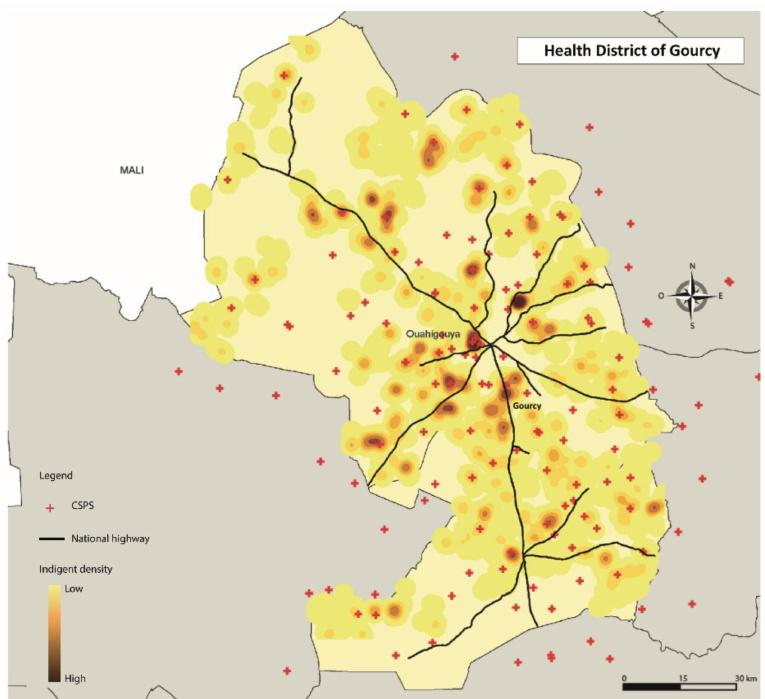
Figure 2. Geographical concentration of the respondents in Gourcy.